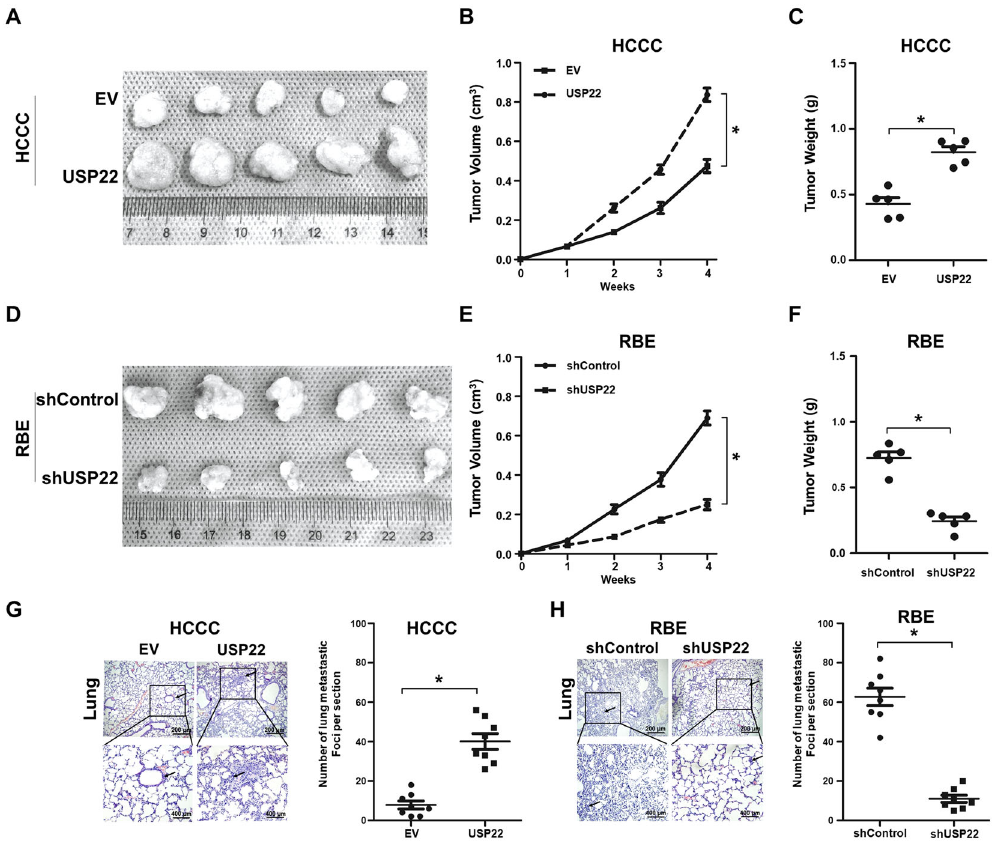
Fig. 3 USP22 promotes CCA tumorigenesis and metastasis in vivo. A – F Each of 1 × 10 7 HCCC-USP22, HCCC-EV, RBE-shUSP22 or RBE- shControl cells were subcutaneously injected into the fl anks of 5-week-old nude mice. Tumour volume was monitored once a week; when they reached the maximum permitted volumes, mice were sacri fi ced, and tumours were weighted (* p < 0.05, n = 5). G – H Each of 1 × 10 7 HCCC-USP22, HCCC-EV, RBE-shUSP22 or RBE-shControl cells were injected into the tail veins of nude mice. After 6 weeks, animals were sacri fi ced, and their lungs were harvested and fi xed for H&E staining. Numbers of metastatic foci were quanti fi ed. Data are shown as the mean ± SD (* p < 0.05, n = 8). Representative images of metastatic foci in sections of the